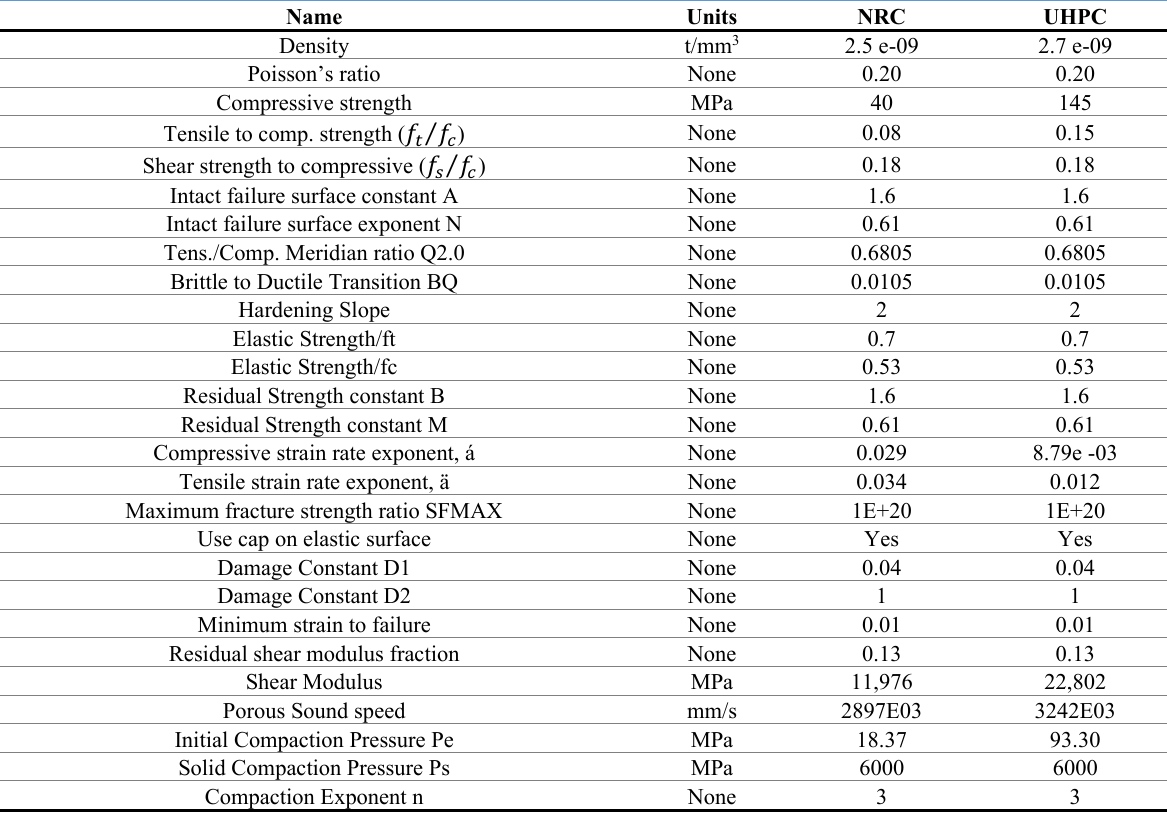
Table 2 - Material model properties for RHT concrete model [10],